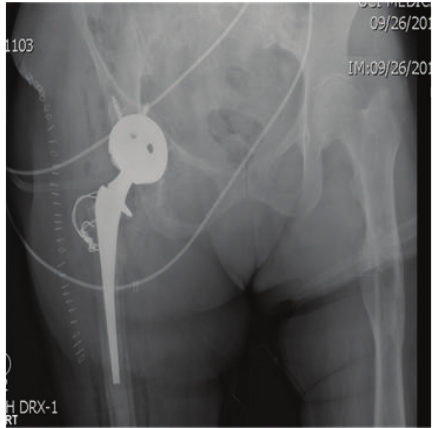
Figure 7: Postoperative radiograph status after reduction of dislo- cated hip.